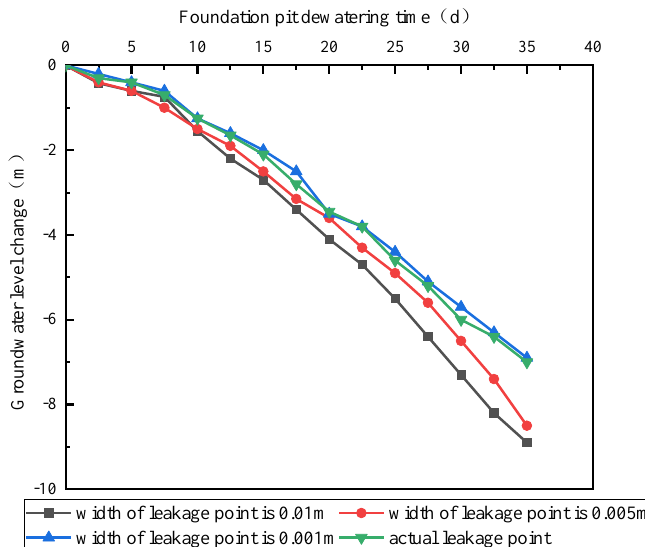
Figure 16. Numerical analysis and comparison of the amount of groundwater level change in the actual project.